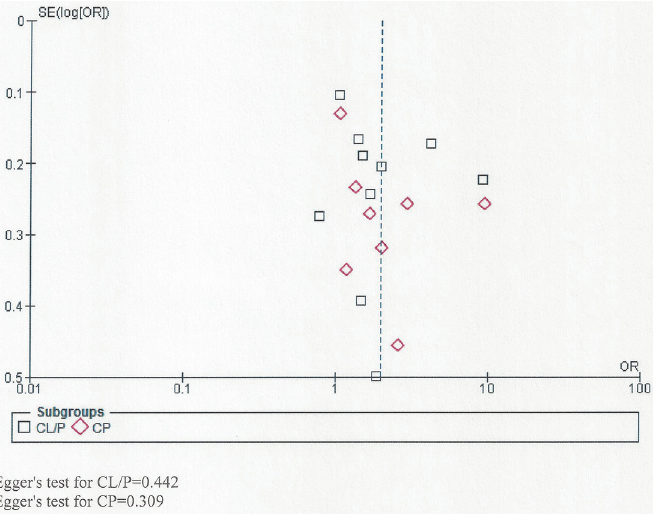
Fig 9. Funnel plot for studies showing the relationship between passive smoking and both CL/P and